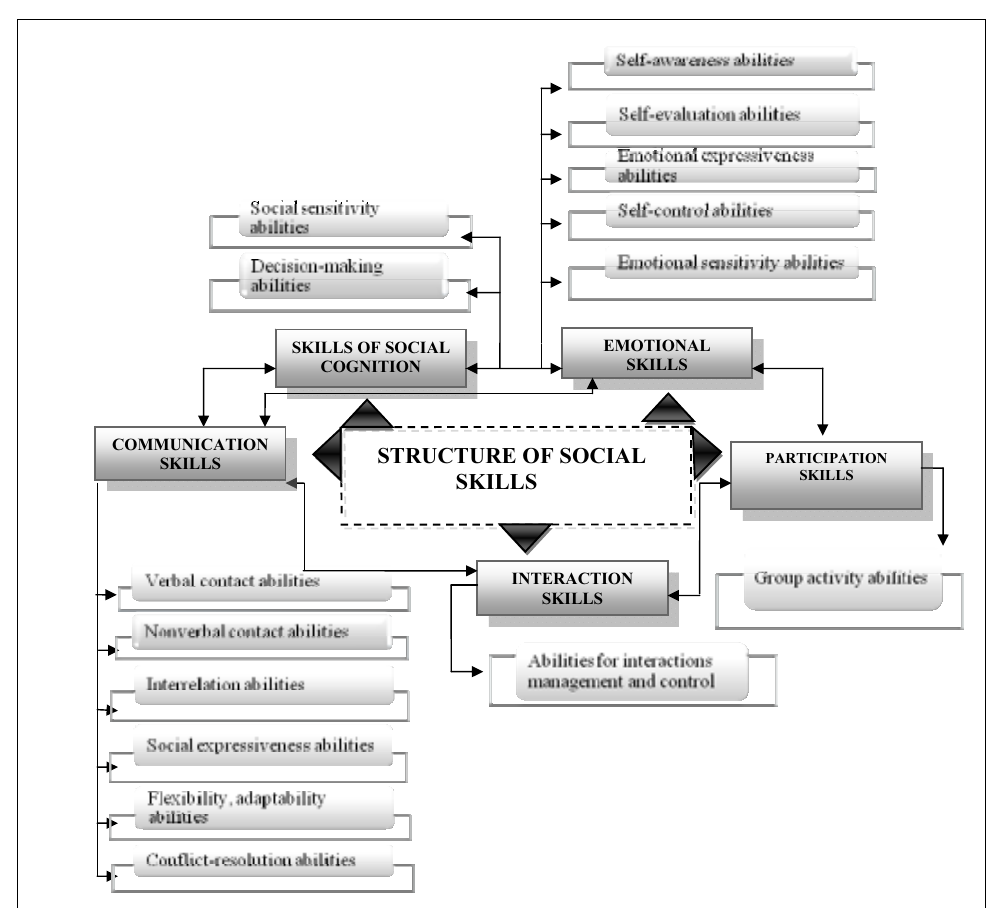
Figure. Structural model of social skill components